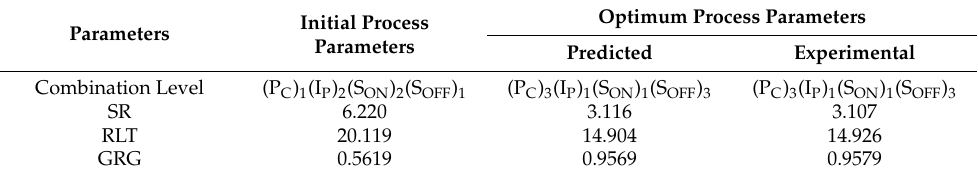
Initial Process Parameters